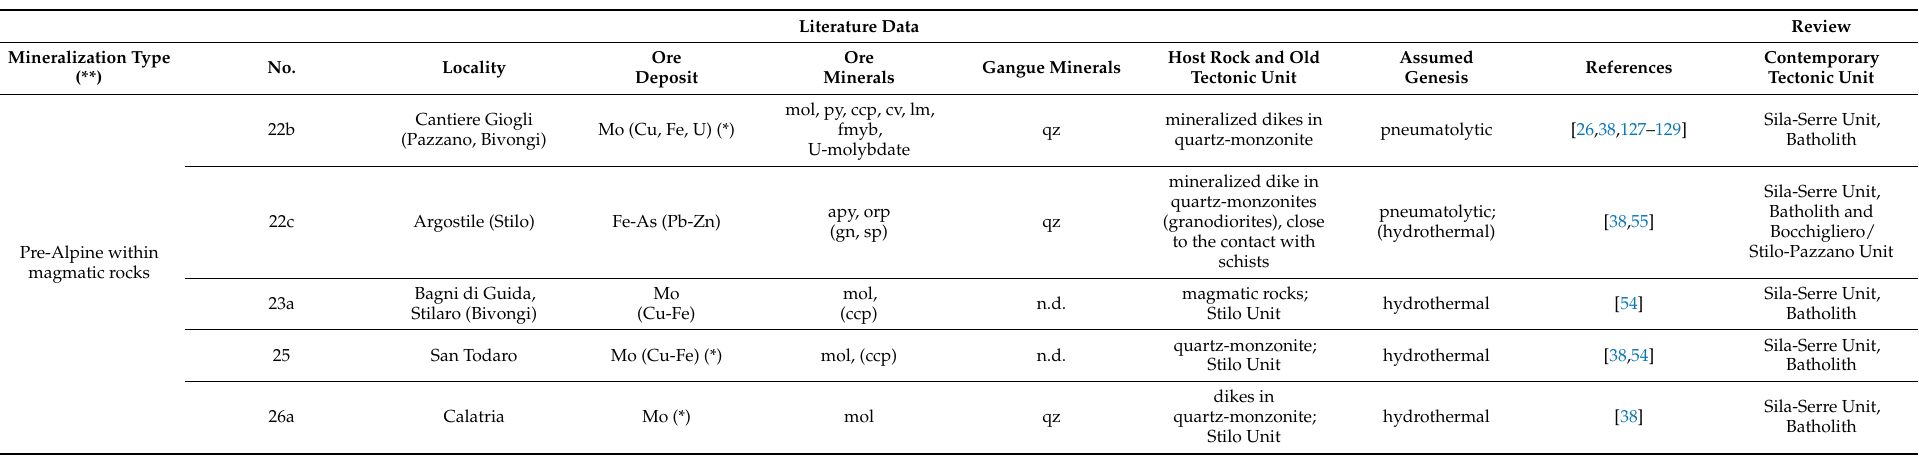
Table A2. Mineralization sites and geological framework of the Serre